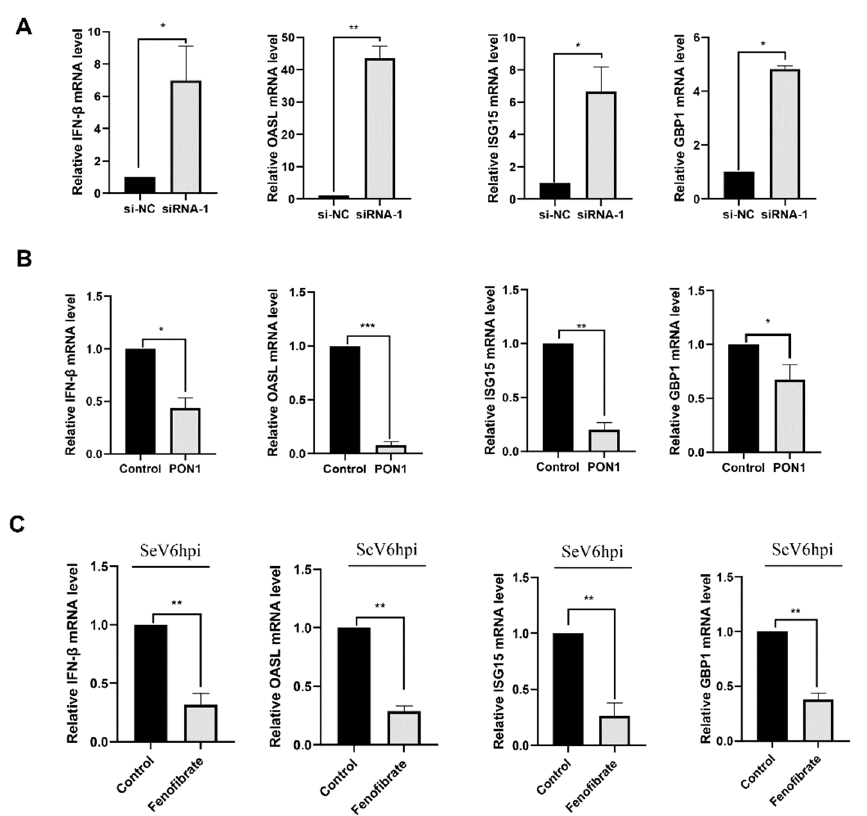
Figure 6. PON1 negatively regulates the type I IFN signaling pathway. ( A ) The knockdown of PON1 expression increases the expression of IFN- β and several ISGs. PAMs were transfected with PON1-specific siRNA-1 and a negative control for 24 h, and the mRNA levels of IFN- β , ISG15, OASL, and GBP1 were determined by qPCR. ( B ) PON1 overexpression results in decreased expression of IFN- β and several ISGs. Lentivirus was used to mediate the overexpression of PON1 in PAM for 24 h, and mRNA levels of IFN- β , ISG15, OASL, and GBP1 were determined by qPCR. ( C ) PON1 activator results in decreased expression of IFN- β and several ISGs. PAMs were treated with 40 µ M fenofibrate for 24 h and then infected with Sendai Virus (SeV) for 6 h, and the mRNA levels of PON1 were determined by qPCR. Data are presented as the mean ± SD. *, p < 0.05; **, p < 0.01; ***, p < 0.001. The p ‐ value was calculated using a Student’s t ‐ test (two ‐ tails).